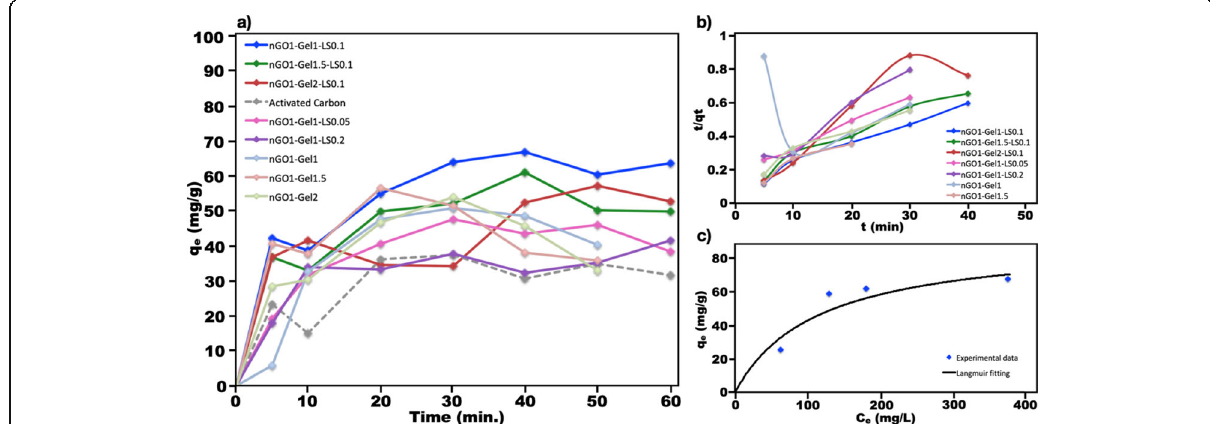
Fig. 4 a Real-time monitoring adsorption curves, b pseudo-second order adsorption kinetics, and c Langmuir adsorption isotherm (for nGO1- Gel1-LS0.1) for Cu(II) adsorption